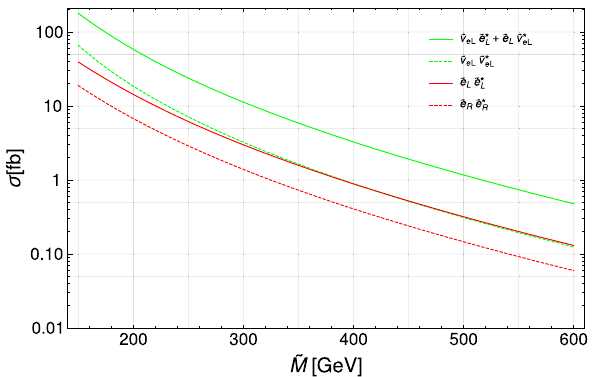
Fig. 1 Various tree-level cross sections in fb for the production of one generation of sleptons and sneutrinos at the LHC with 13 TeV as a function of the corresponding soft SUSY mass parameter ˜ M : green (bright) full line σ( pp → ˜ e L ˜ ν ∗ dashed line σ( pp → ˜ ν eL ˜ ν ∗ red (dark) dashed line σ( pp → ˜ e R ˜ e ∗ breaking parameter M ˜